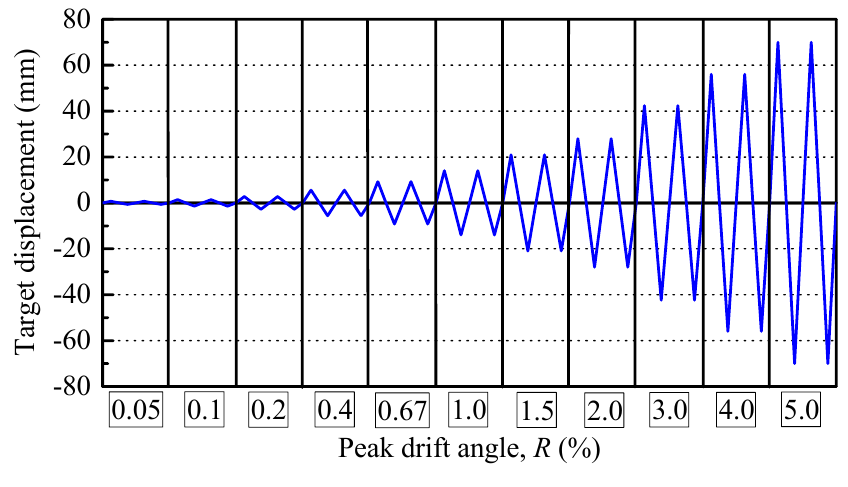
Figure 6. Lateral loading protocol.